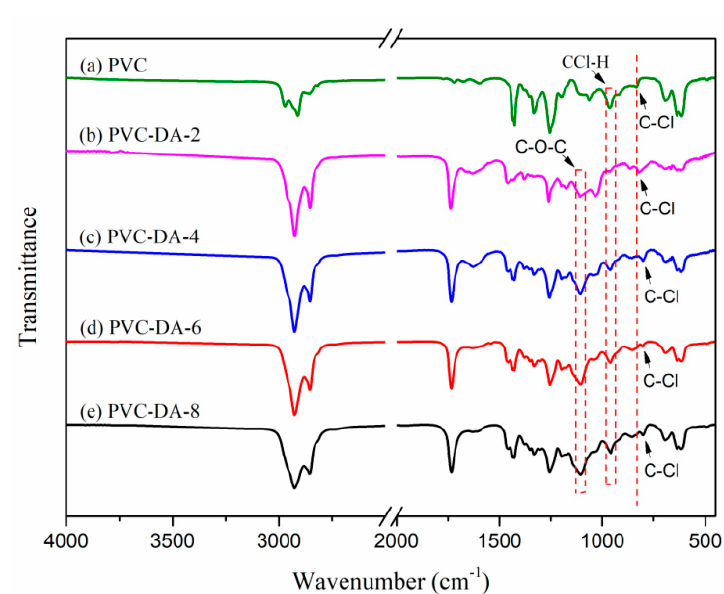
Figure 3. FT-IR spectra of ( a ) PVC, ( b ) PVC-DA-2, ( c ) PVC-DA-4, ( d ) PVC-DA-6, and ( e ) Figure 3. FT ‐ IR spectra of ( a ) PVC, ( b ) PVC ‐ DA ‐ 2, ( c ) PVC ‐ DA ‐ 4, ( d ) PVC ‐ DA ‐ 6, and ( e ) PVC ‐ DA ‐ 8.